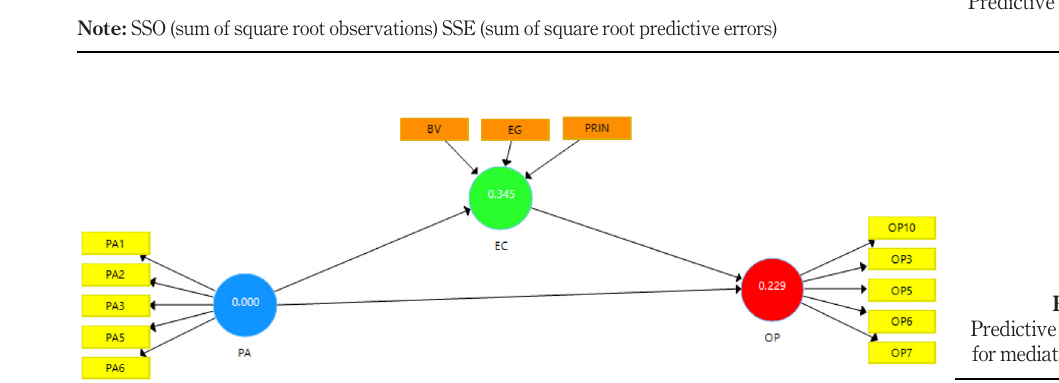
Table VIII. Predictive